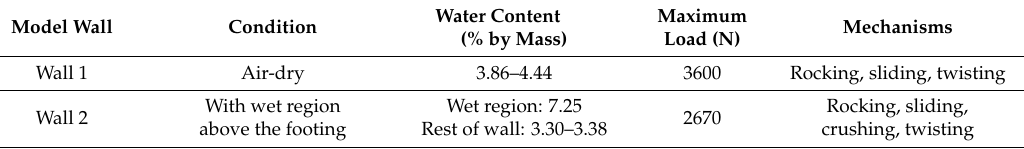
Table 1. Summary of test conditions, maximum loads, and observed mechanisms.